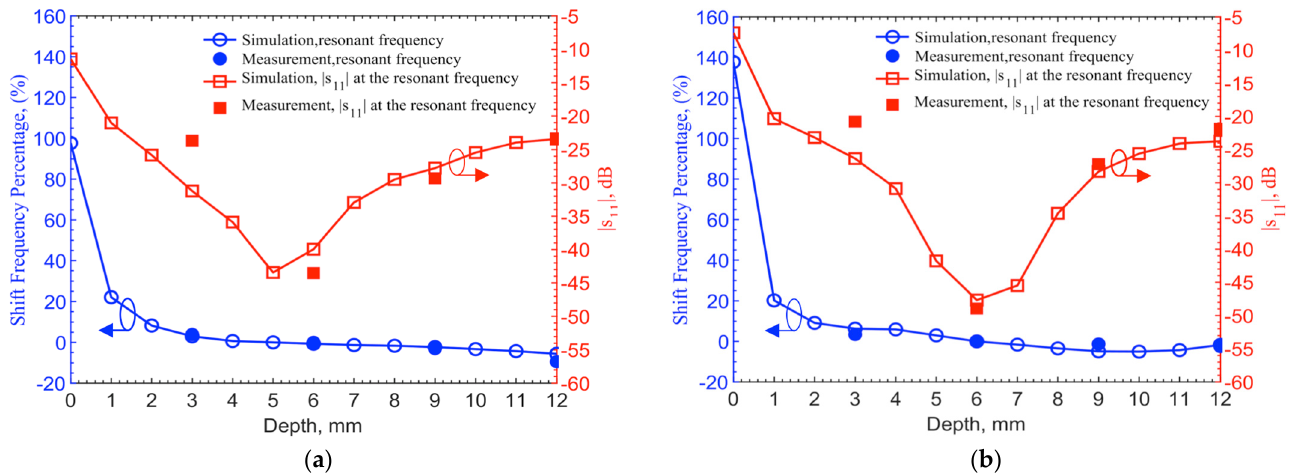
Figure 8. Measurements of ( a ) the 903-MHz design and ( b ) the 2.45-GHz design with tuning pad at depths of 3, 6, 9 and 12 mm in the ground pork phantom.